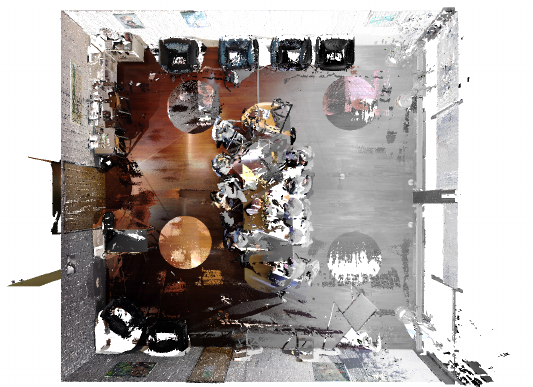
Figure 17. FARO laser scanned point cloud after downsampling.